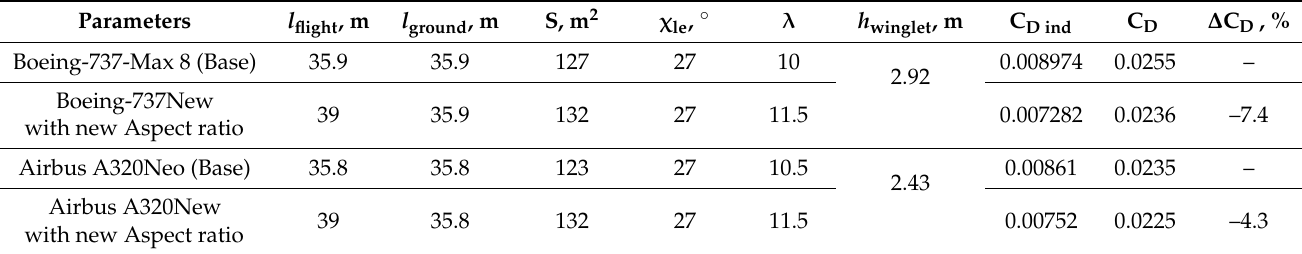
Table 2. Dependence of changes in C Dind and C D on wing aspect ratio for Boeing 737Max 8 and Airbus